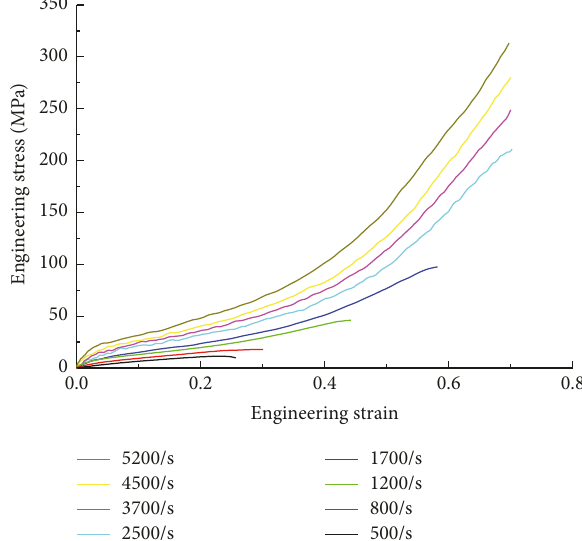
Figure 5: Engineering stress-strain curves of high-damping rubber material.